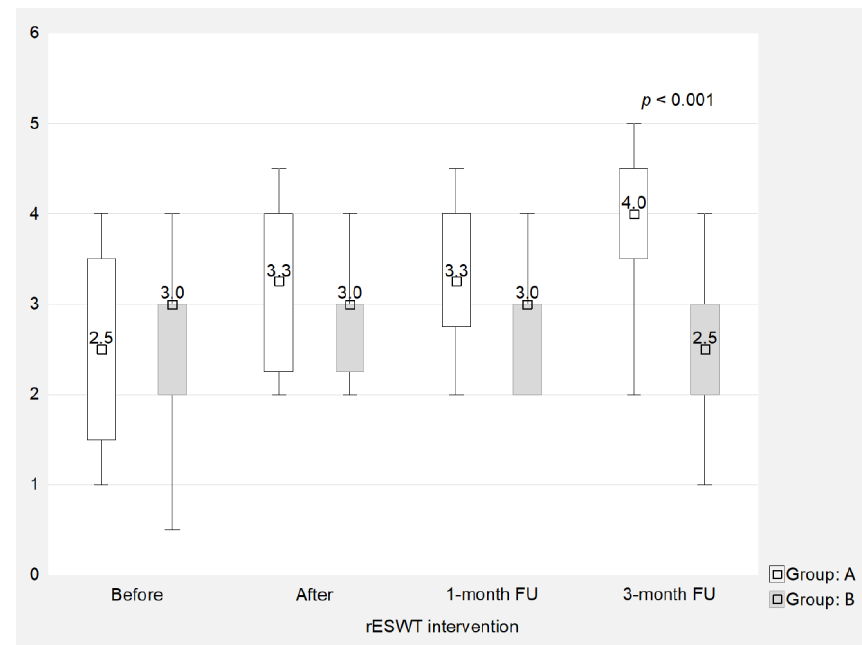
Figure 5. Comparison of functional outcomes (RMQ) between two groups (points). RMQ: Roland–Morris Questionnaire. J. Clin. Med. 2020 , 9 , 568